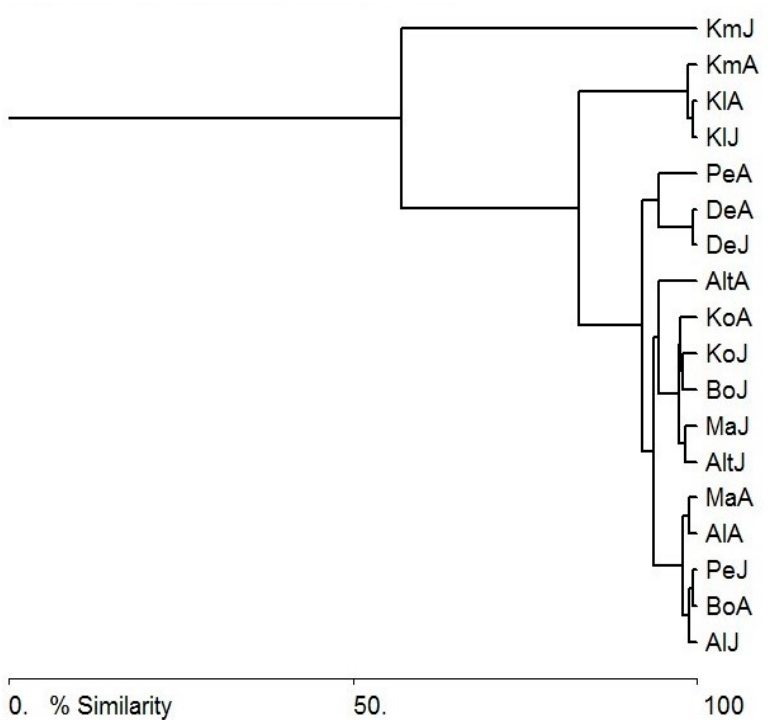
Figure 2. Chemical variables similarity assessment according to the Bray-Curtis cluster analysis.